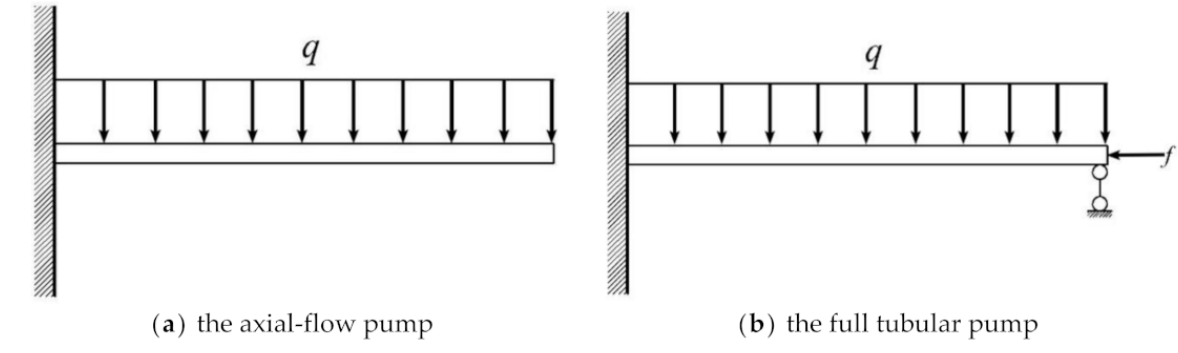
Figure 12. Simplified figures of impeller structural mechanics: ( a ) the axial-flow pump, ( b ) the full tubular pump.